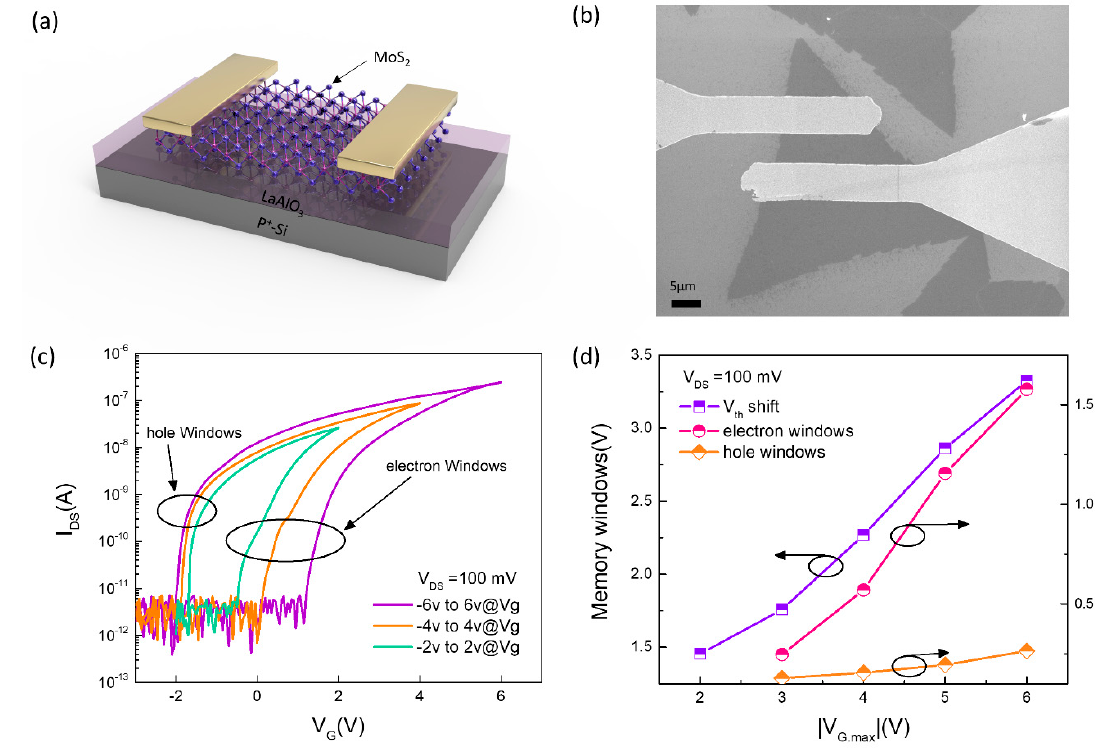
Figure 2. ( a ) The schematic diagram of memory cell with the MoS 2 channel and LaAlO 3 charge trapped layer. ( b ) The memory cell in the scanning electron microscope (SEM). ( c ) The double direction transfer characteristic at different sweep voltages. ( d ) The memory windows as a function of the voltage |V G.MAX |. The initial threshold corresponding to the threshold voltage sweeping the gate voltage ± 2.